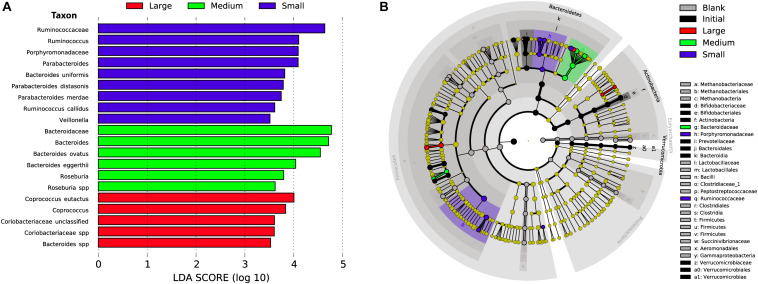
Linear discriminant analysis of taxa representing the small, medium, and large sizes of maize bran. We also included initial and blank communities in the analysis in order to avoid misrepresentation of taxa to size fractions that were overrepresented in controls. (A) Taxa with LDA scores > 3.5 in the small (180–250 μm), medium (250–300 μm), and large (500–850 μm) size fractions at 48 after inoculation; linear discriminants of initial and blank conditions are not shown. (B) Cladogram showing taxa that are overrepresented in the small, medium, and large maize bran fractions at LDA > 3.5 compared to abundances in the initial inoculum and blank (without carbon substrate).